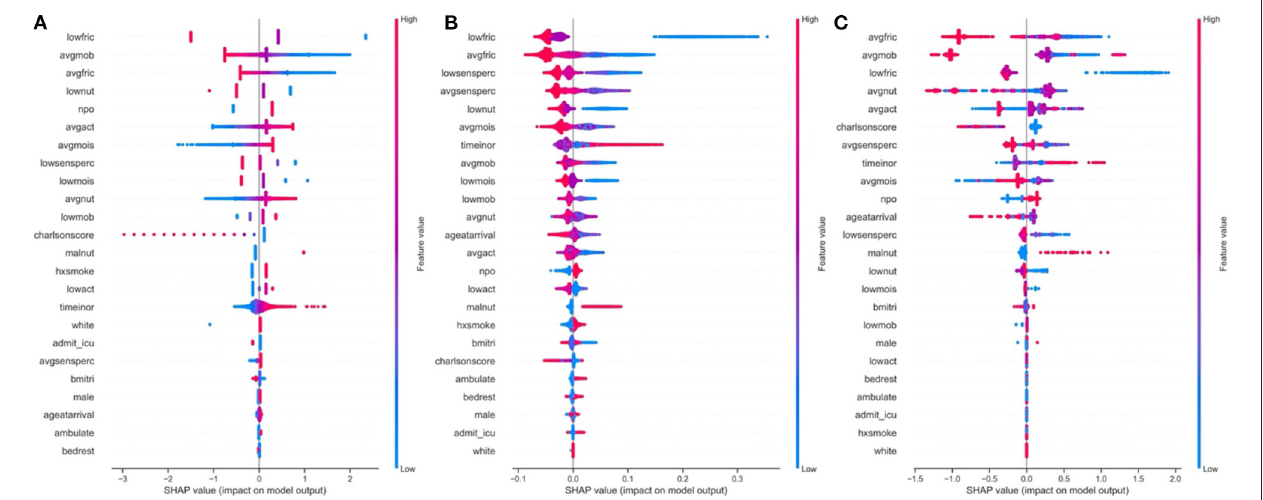
FIGURE 3 | Global predictor importance (SHAP summary plots) of patient specific factors for: (A) Logistic Regression, (B) Random Forest, (C) XGBoost; The plots for each model (A–C) consist of a point per patient hospitalization across all predictors. The points are colored by the features value and lateral displacement from the centerline indicates the importance of that feature for that particular individual. Values that increase the probability of being classified as a HAPI are displayed to the right of the centerline of each plot; red dots indicate a high feature value, while blue dots indicate a low feature value. For instance, increased HAPI incidence was associated with decreases in the Braden subscale score for low friction, average mobility, average friction and low nutrition in the logistic regression plot (A)